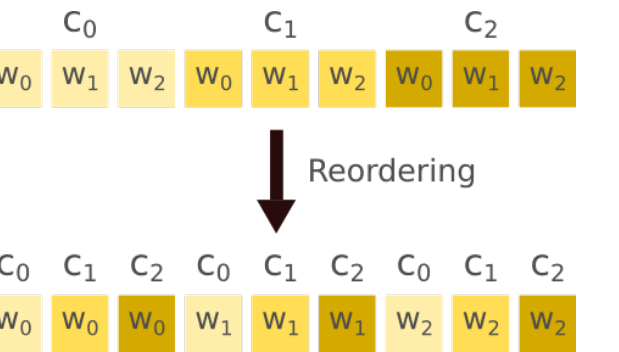
Figure 1. Weights reordering on a filter that expects 3 input channels and whose kernels have size 3.